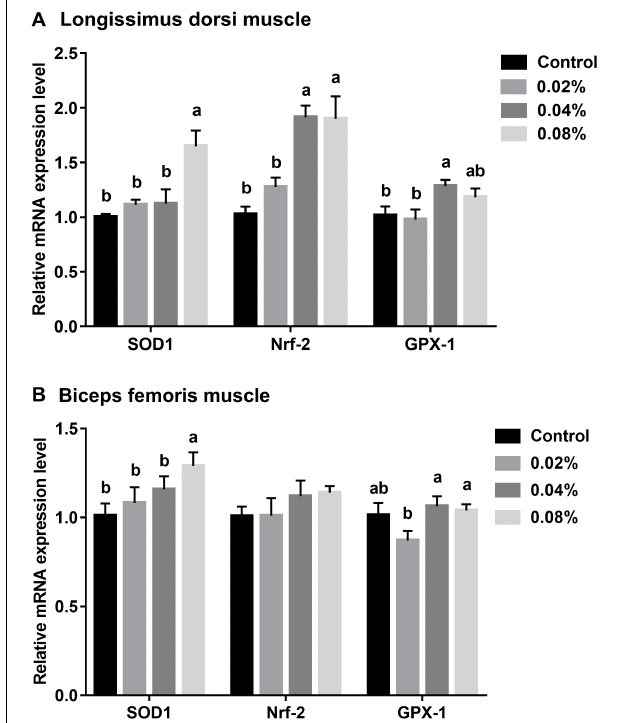
FIGURE 1 | Effects of different levels of dietary CGA supplementation on relative mRNA expression levels of antioxidant-related genes in LD (A) and BF (B) muscles of finishing pigs. Values are means, with their standard errors represented by vertical bars. Values with different letters differ ( P < 0.05).